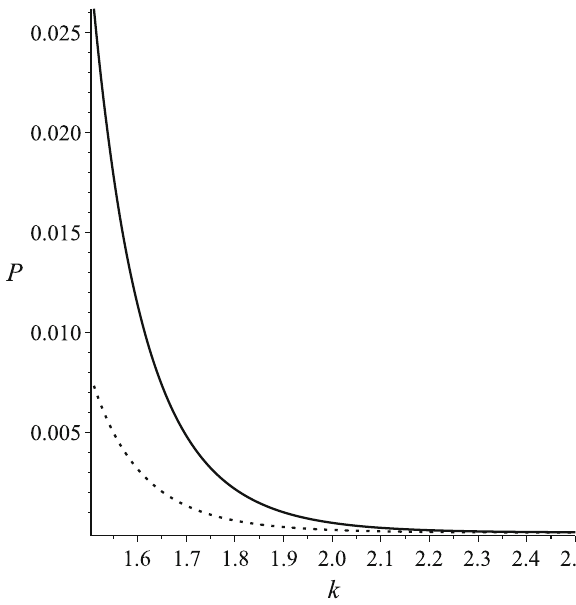
Fig. 4 P as a function of k for p / p (cid:8) = 0 . 001 solid line and p / p (cid:8) = 0 . 003 the point line. Angle β − ϕ =